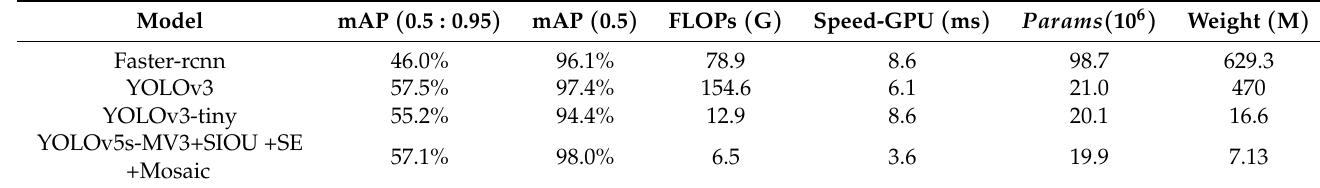
Table 6. Comparison with other network training